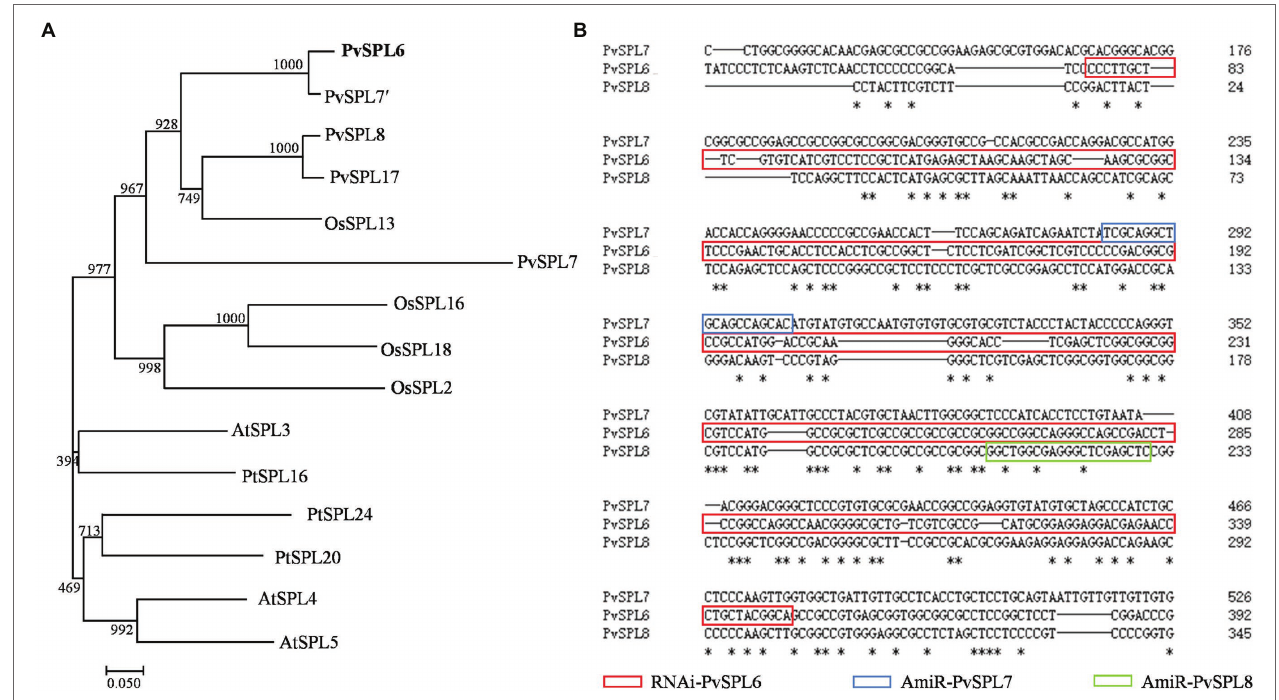
FIGURE 1 | Molecular characterization and sequence analysis of PvSPL6 . (A) Phylogenetic analysis of SQUAMOSA PROMOTER BINDING-LIKEs (SPLs) in clade OG2 in dicot and monocot plant species. A maximum likelihood tree was constructed in PhyML version 3.0 based on multiple alignments of deduced protein sequences from Panicum virgatum (PvSPL6, Pavir.2KG430400; PvSPL7 ′ , Pavir.2NG503700; PvSPL8, Pavir.2KG430000; and PvSPL17, Pavir.2NG503500), Oryza sativa (OsSPL2, LOC_Os01g69830; OsSPL13, LOC_Os07g32170; OsSPL16, LOC_Os08g41940; and OsSPL18, LOC_Os09g32944), Arabidopsis thaliana (AtSPL3, AT2G33810; AtSPL4, AT1G53160; and AtSPL5, AT3G15270), and Populus trichocarpa (PtSPL16, Potri.011G055900; PtSPL20, Potri.001G398200; and PtSPL24, Potri.007G138800). Bootstrap support values (>50%) based on 1,000 replications are given at the nodes. The sequence data were retrieved from Phytozome and/or Genbank. (B) Sequence alignment of PvSPL6 , PvSPL7 , and PvSPL8 . The red box indicates the RNAi regions of PvSPL6 ; the blue box indicates the artificial microRNA (amiRNA) regions of PvSPL7 ; and the green box indicates the amiRNA regions of PvSPL8 . The artificial microRNA regions mean the nonconserved regions of PvSPL7 and 8 . The amiRNAs of PvSPL7 and 8 were to knockdown the expression levels of PvSPL7 and 8 , respectively. * means the identical